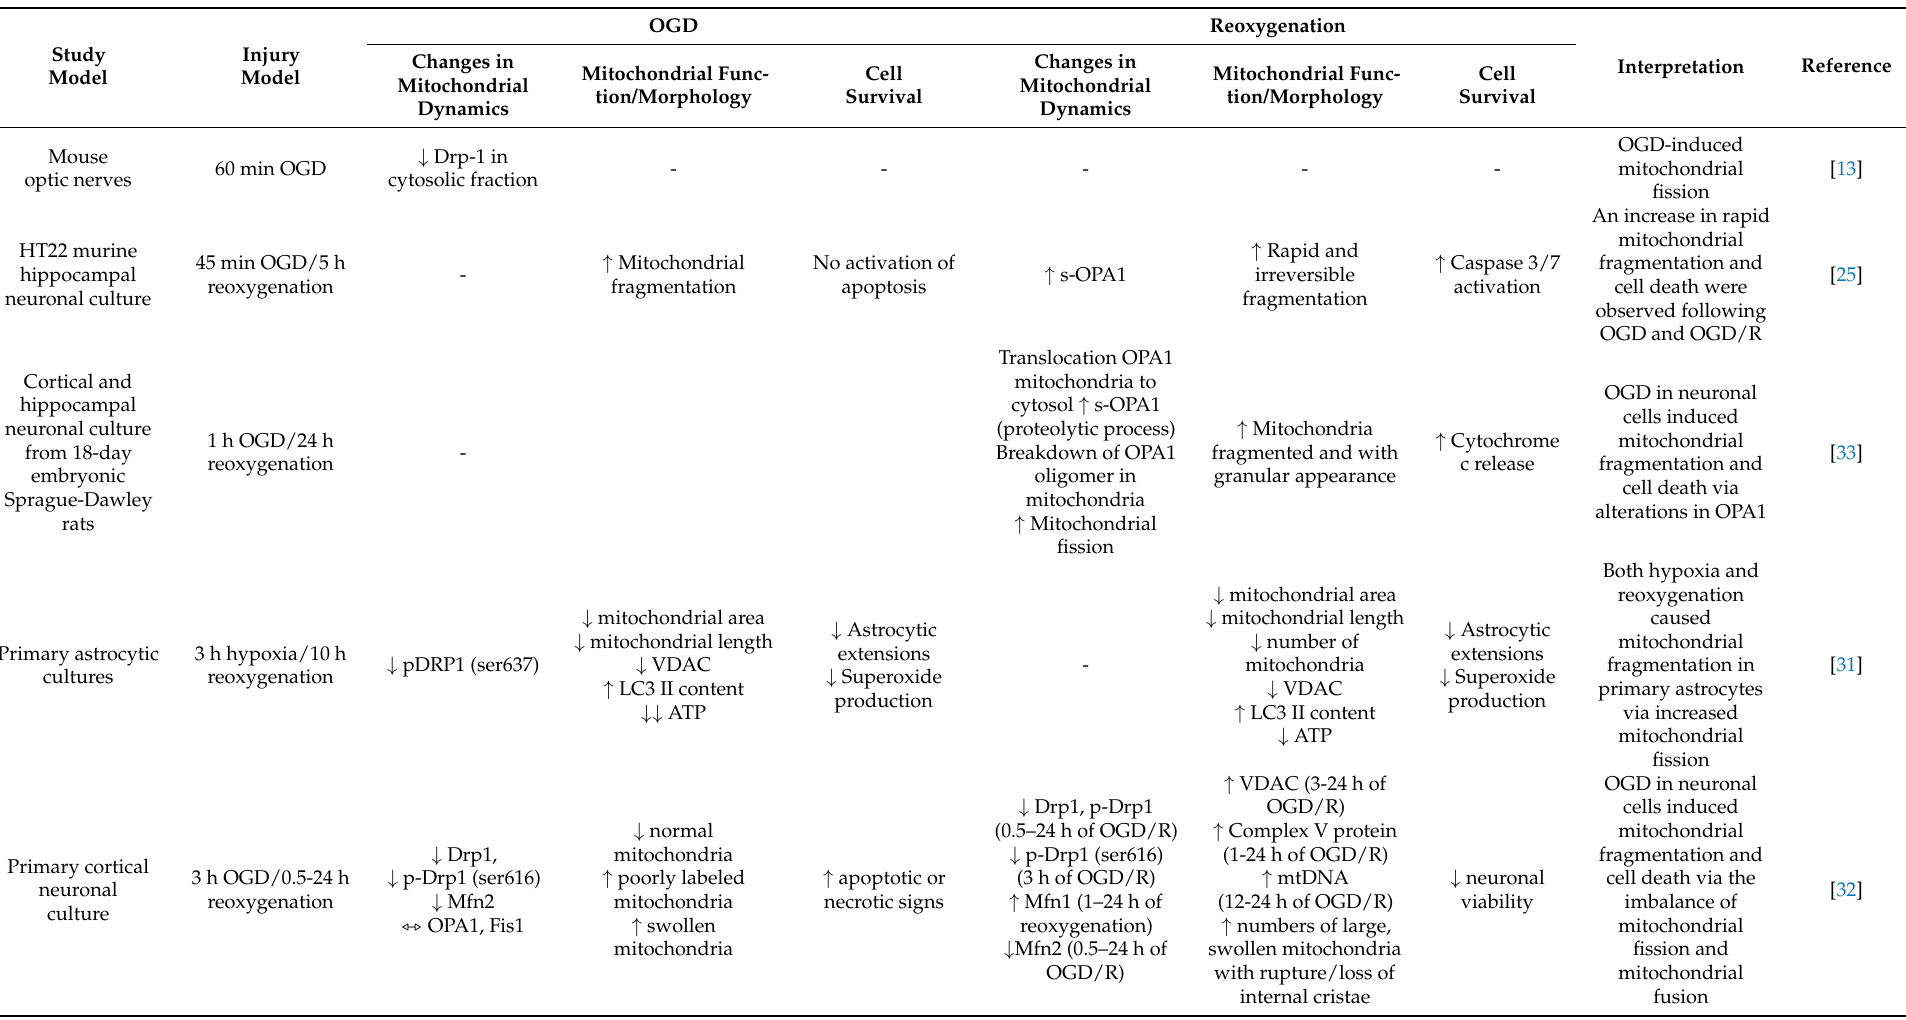
Table 1. Evidence in the alterations in mitochondrial dynamics following oxygen-glucose deprivation/reoxygenation: in vitro